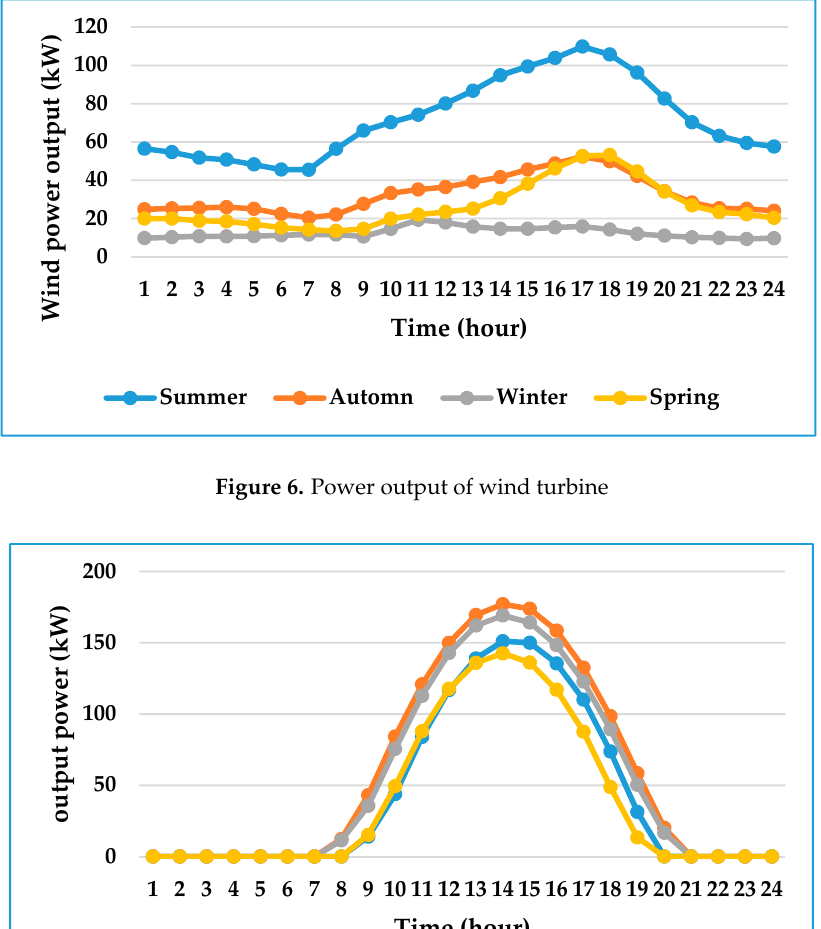
Figure 7. Power output of solar irradiance